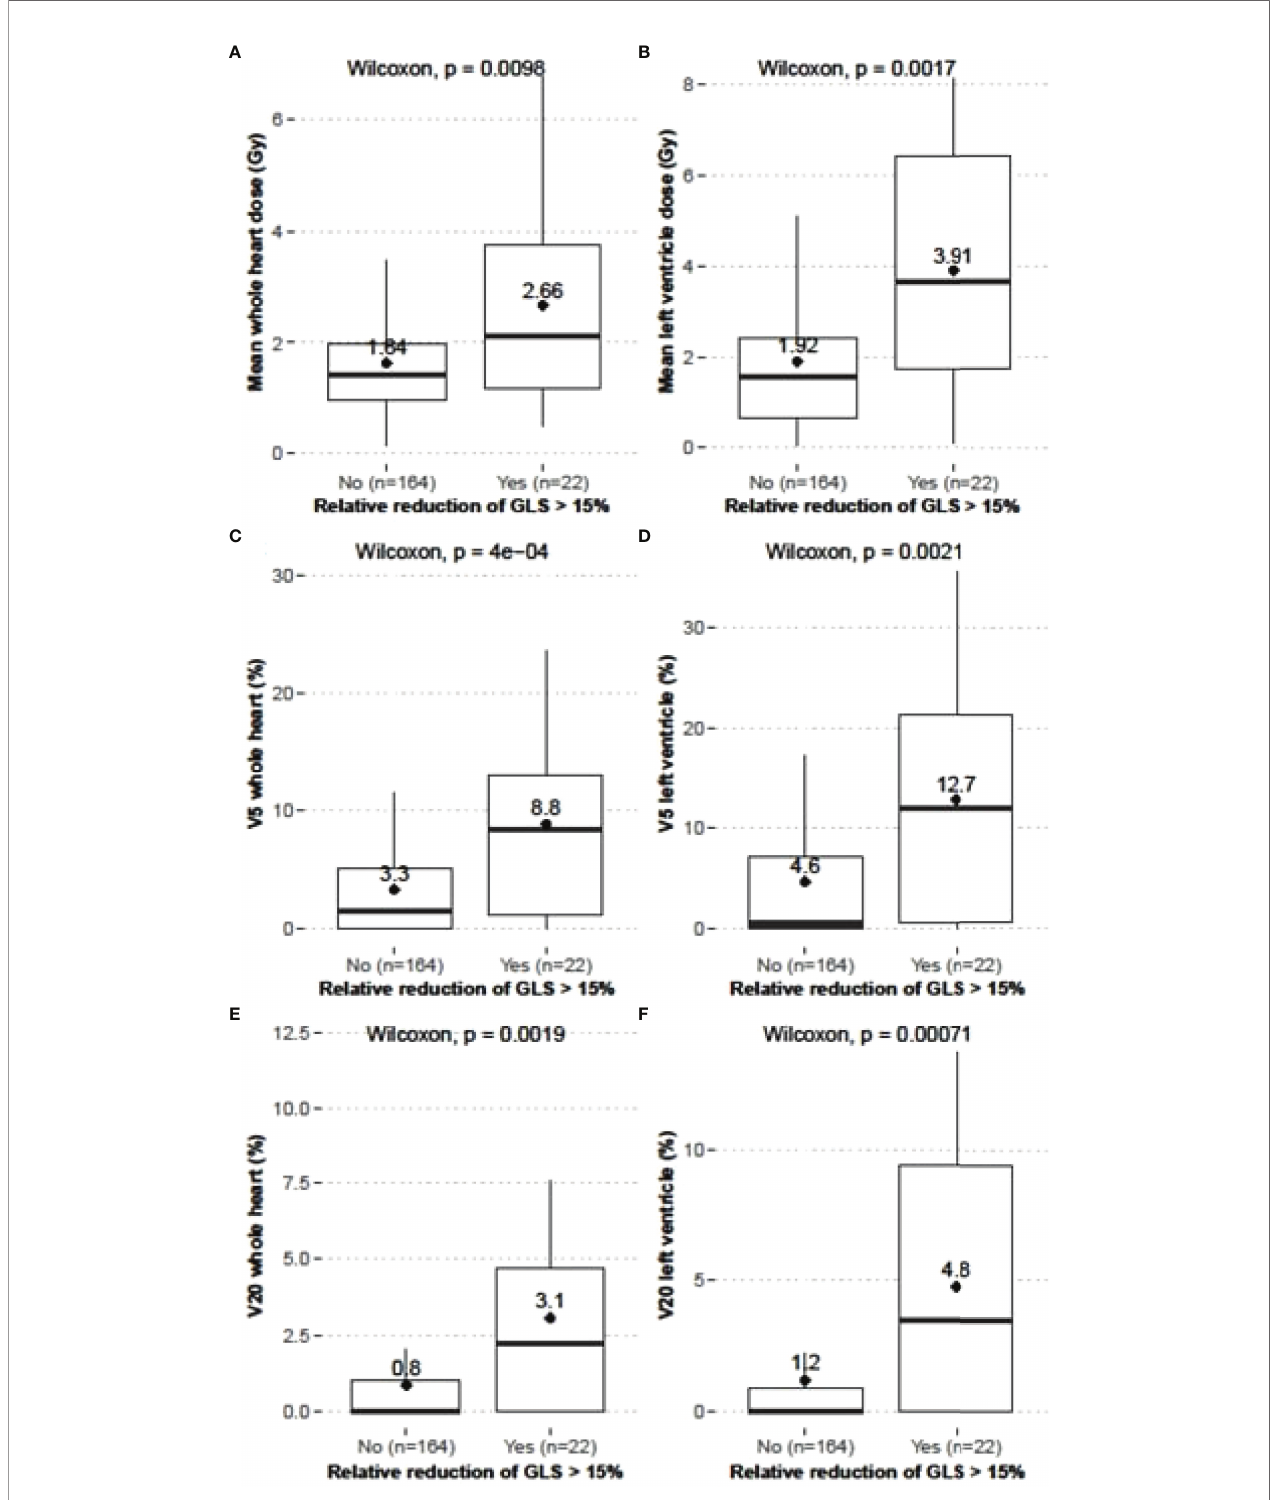
FIGURE 2 | Comparisons of dose-volume parameters between BC patients with or without a reduction of GLS >15%; D mean to WH (A) and LV (B) (Gy), V 5 of WH (C) and LV (D) , and V 20 of WH (E) and LV (F) ; mean values: numerical and ♦